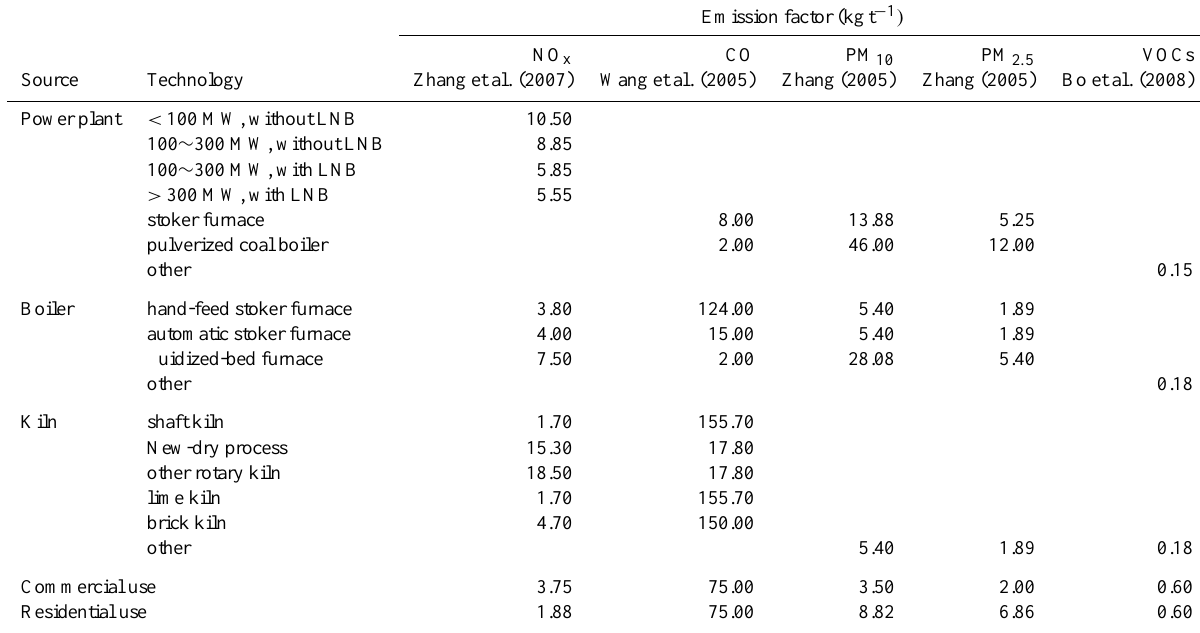
Table 1. Emission factors of coal combustion